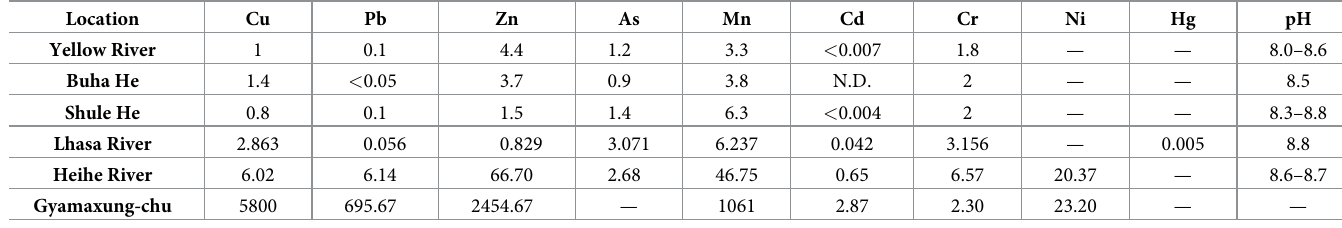
Table 5. Comparison of heavy metal contents in other rivers in Tibet. Location